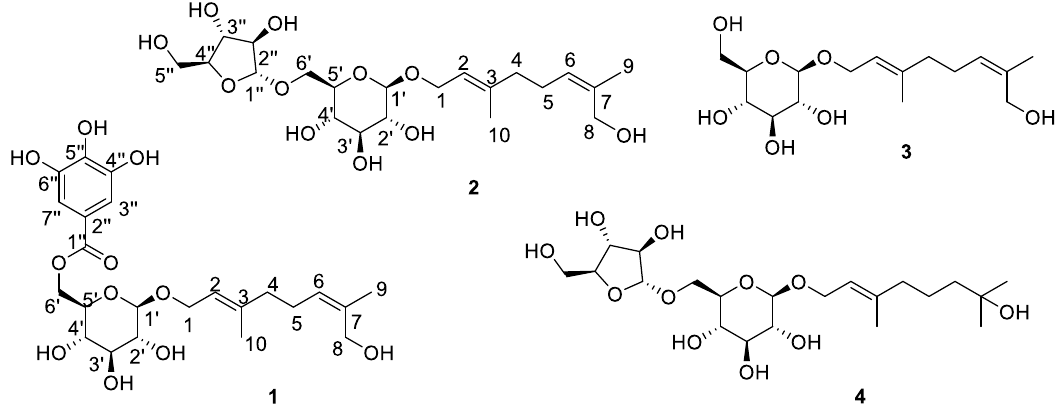
Figure 1. The structures of compounds 1 – 4 isolated from Sanguisorba officinalis .